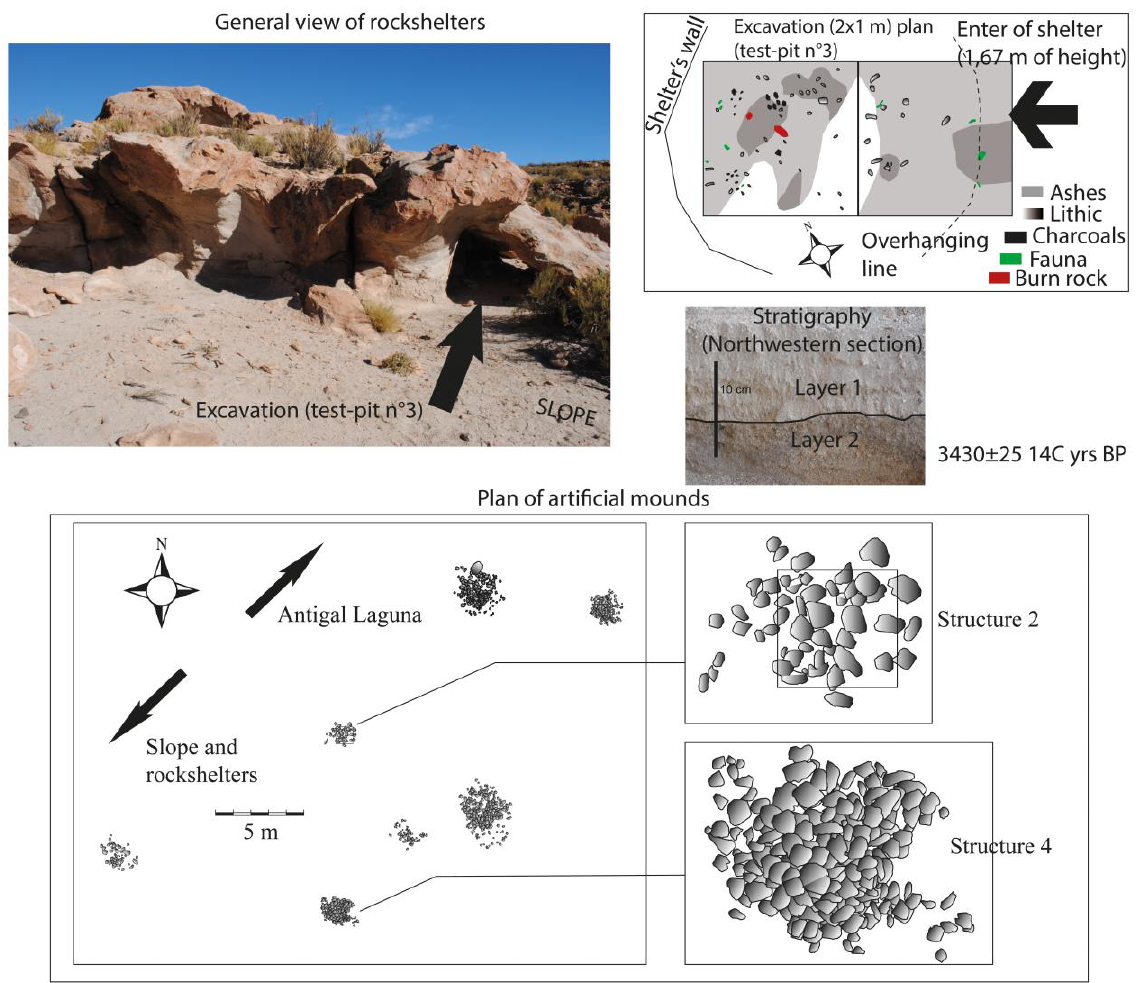
Figure 2. Laguna Media 7. General view of rock shelter, Excavation plan, stratigraphic column and artificial mounds sector